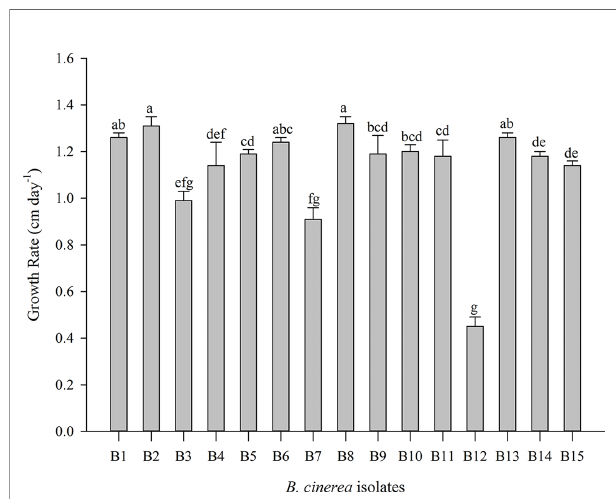
FIGURE 1 | Mycelial growth rate of 15 Botrytis cinerea isolates in dark condition. Data are presented as mean of six replicates with standard deviation. Different letters indicate statistical differences among B. cinerea isolates based on Kruskal-Wallis test with Bonferroni correction (Dunn test, p ≤